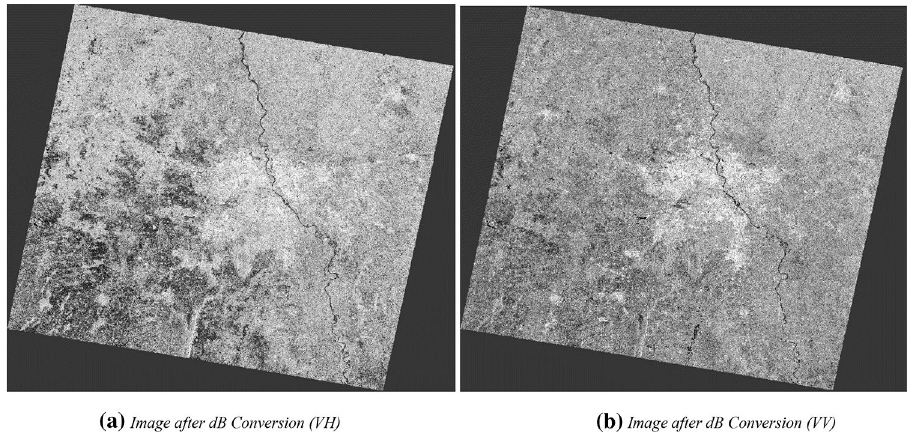
Figure 12. Converted output dB image in dual